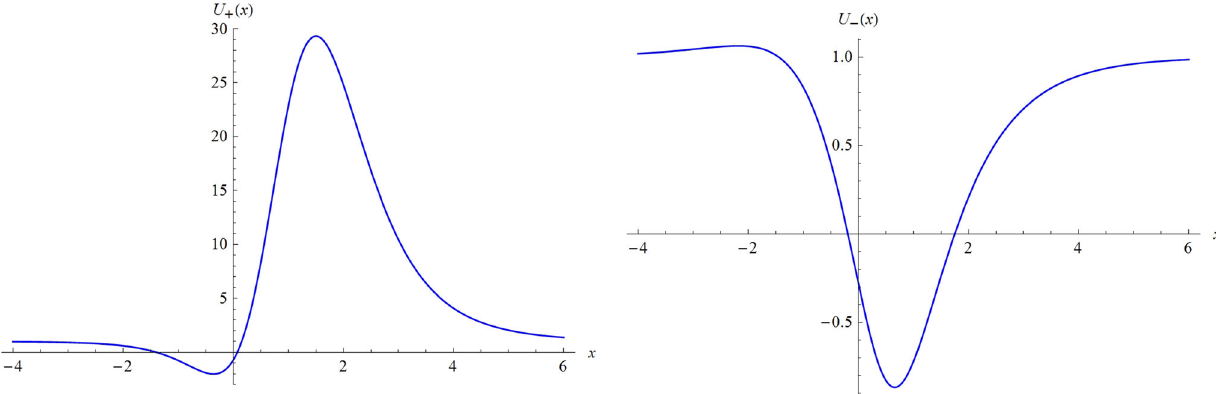
Fig. 11 Quantum-mechanical potentials U + (on the left) and U − (on the right) for α = β = c 1 = 1